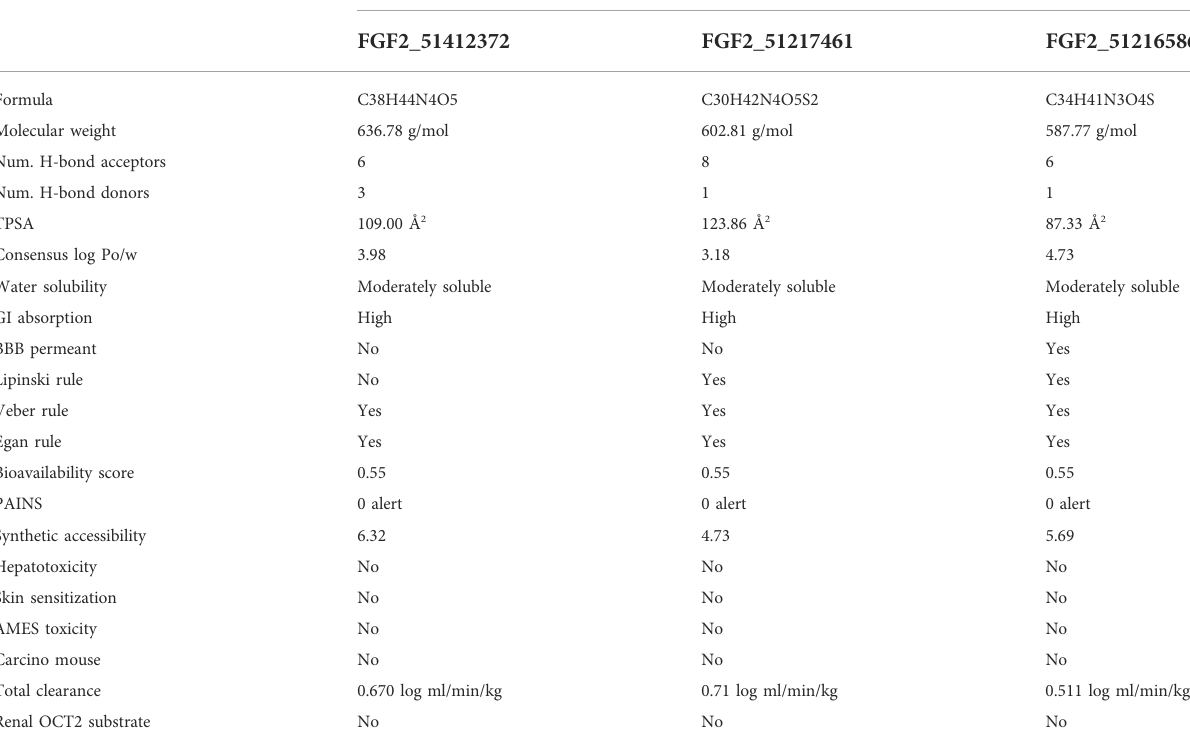
TABLE 3 ADMET analysis of selected